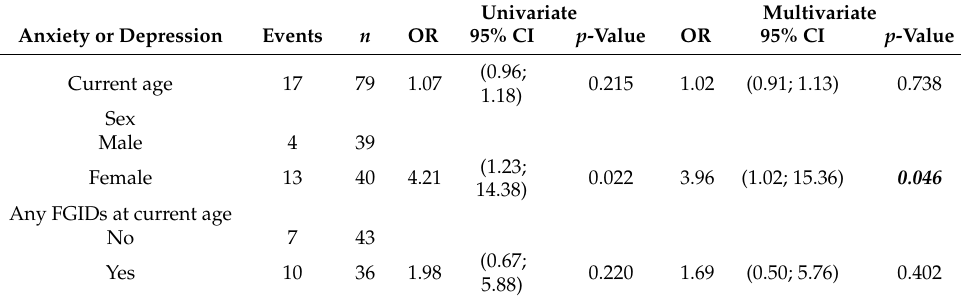
Table 2. Risk factors for anxiety or